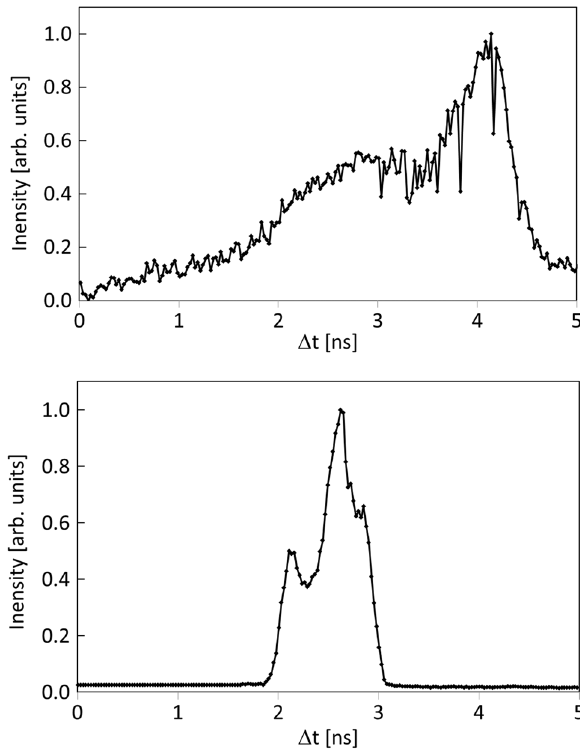
FIG. 7. Bunch shape measurement for HLI beam at 1 . 366 MeV/u (top) and at the same energy for the matched case with rebuncher R1 and R2 (bottom).